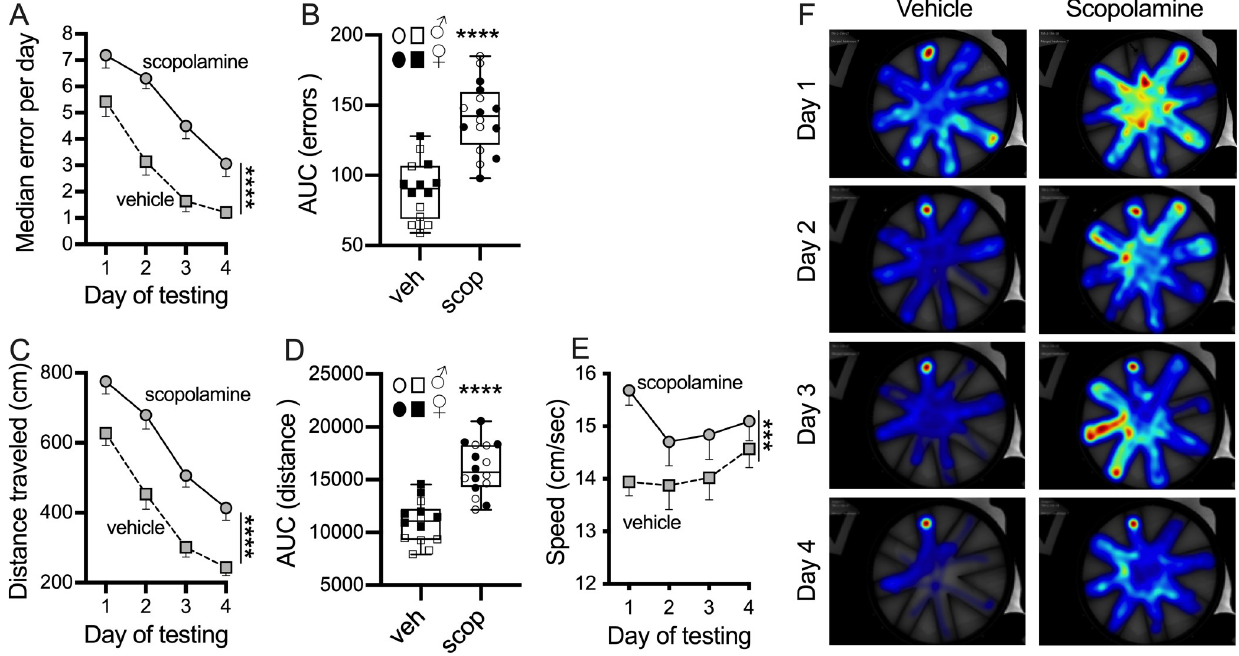
Fig 4. Validation of RAWM test using scopolamine as a positive control, to induce cognitive impairments. Male and female mice were tested in the RAWM test, scopolamine was given (1 mg/Kg; scop) 30 minutes prior to the start of testing on each day. (A) The median of errors made during the hidden platform over the 4-day test, and (B) area under the error curve showed that scopolamine disturbs learning and memory. In (C) the average distance traveled and (D) area under the distance curve confirmed that scopolamine-treated mice explore more the maze to escape. (E) Speed after scopolamine- treatment is increased. (F) Representation of time spent throughout the RAWM test using a heat map. Vehicle mice had a strong preference for the goal arm compared to scopolamine-treated mice that spend more time investigating the entire pool. Blue indicates that the mouse spends less time in that area of the maze, while red demarcates where the mouse spends the majority of its investigative time. In the AUC graphs male results are represented with the open symbol, instead females with closed symbol. ��� p = 0.0007, ���� p < 0.0001. Vehicle (n = 14; 7/7 ♂ / ♀ ); scopolamine (n = 16; 8/8 ♂ / ♀ ).